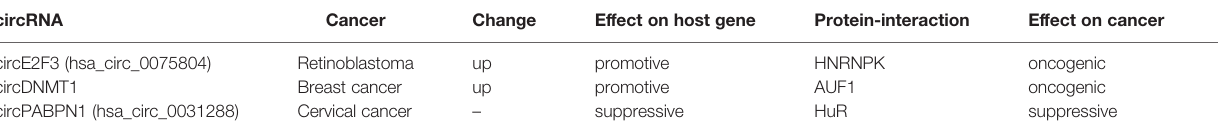
TABLE 3 | circRNAs regulate the stability of host gene mRNA in human cancer.